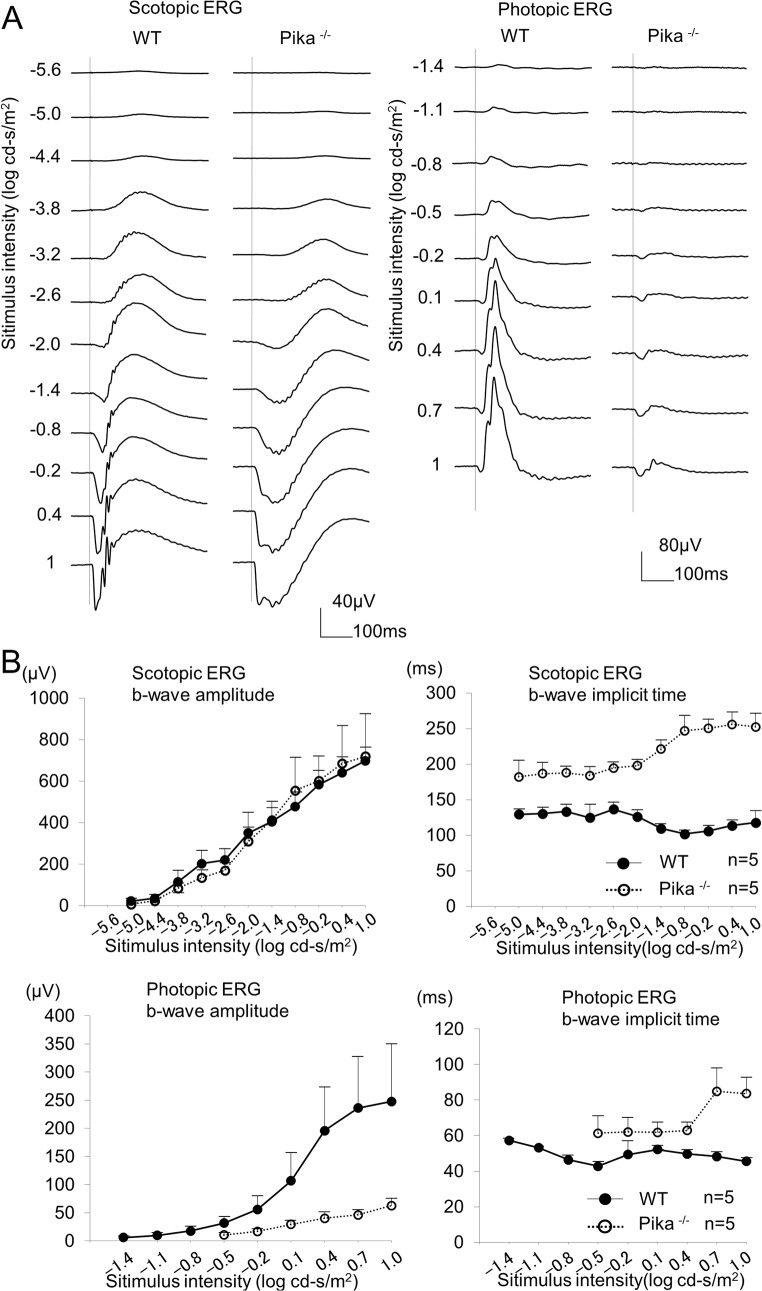
Effect of different stimulus intensities on the amplitudes of the a- and b-waves of the scotopic (A) and photopic (B) ERGs of wild type (WT) and Pika-/- mice.(A) Scotopic flash ERGs elicited by 11 different stimulus intensities (from -5.0 to 1.0 log cd-s/m2), and photopic flash ERGS elicited by 9 different stimulus intensities (from -1.4 to 1.0 log cd-s/m2) recorded in a representative WT mouse and a representative Pika-/- mouse. (B) The intensity–response curves of the mean scotopic and photopic b-wave amplitudes of five WT mice and five Pika-/- mice are shown in the upper left and lower left panels respectively. The amplitudes of the scotopic b-wave of WT mice were not significantly different from that of Pika-/- mice (P >0.05: repeated measures ANOVA). However, the amplitudes of the photopic b-wave of Wt mice were significantly different from Pika-/- mice (P <0.05: repeated measures ANOVA). In addition, the intensity–response curves of the mean scotopic and photopic b-wave implicit times are shown in the upper right and lower right panel respectively. The implicit times of the scotopic and photopic b-waves of WT mice were significantly different from Pika-/- mice (P <0.05: repeated measures ANOVA).The means ± SDs are plotted. ● = WT mice and ○ = Pika-/- mice.